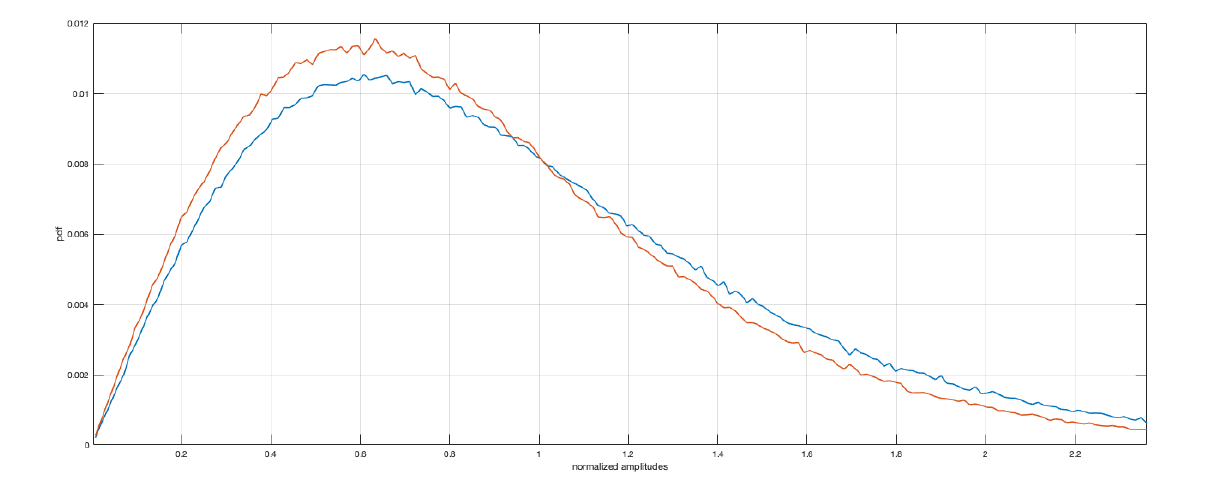
Figure 11. Histogram of focused images amplitudes